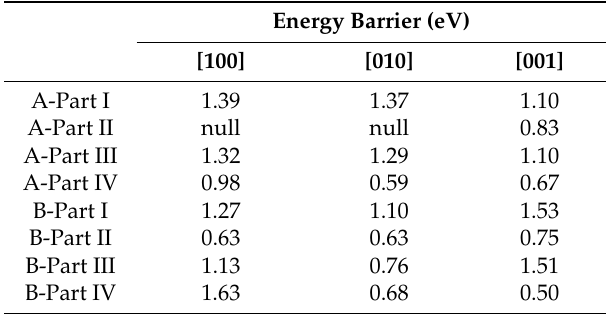
Table 4. Energy barrier for diffusion parts I–IV of diffusion paths in three